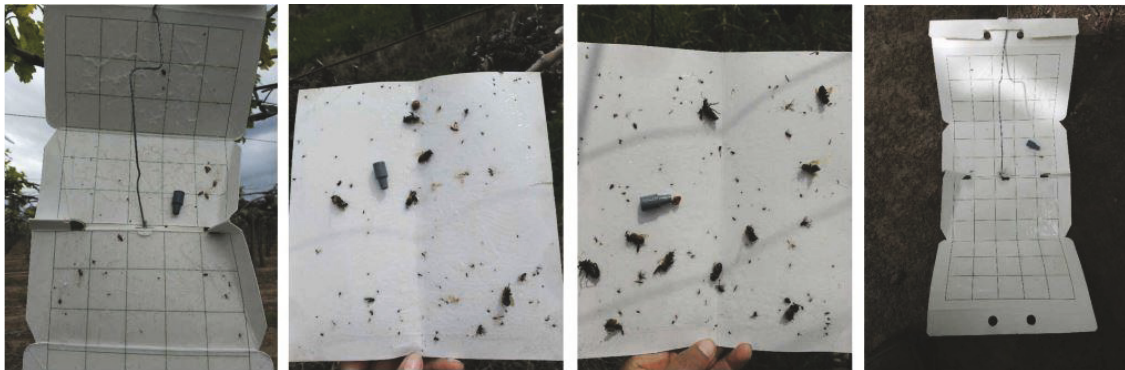
Figure 5: Captures images